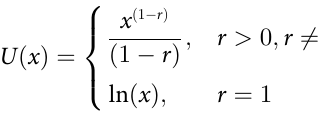
Table 1 describes the differences in domain and framing between treatments.